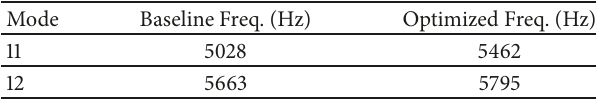
Table 6: Baseline and optimized Impellers natural